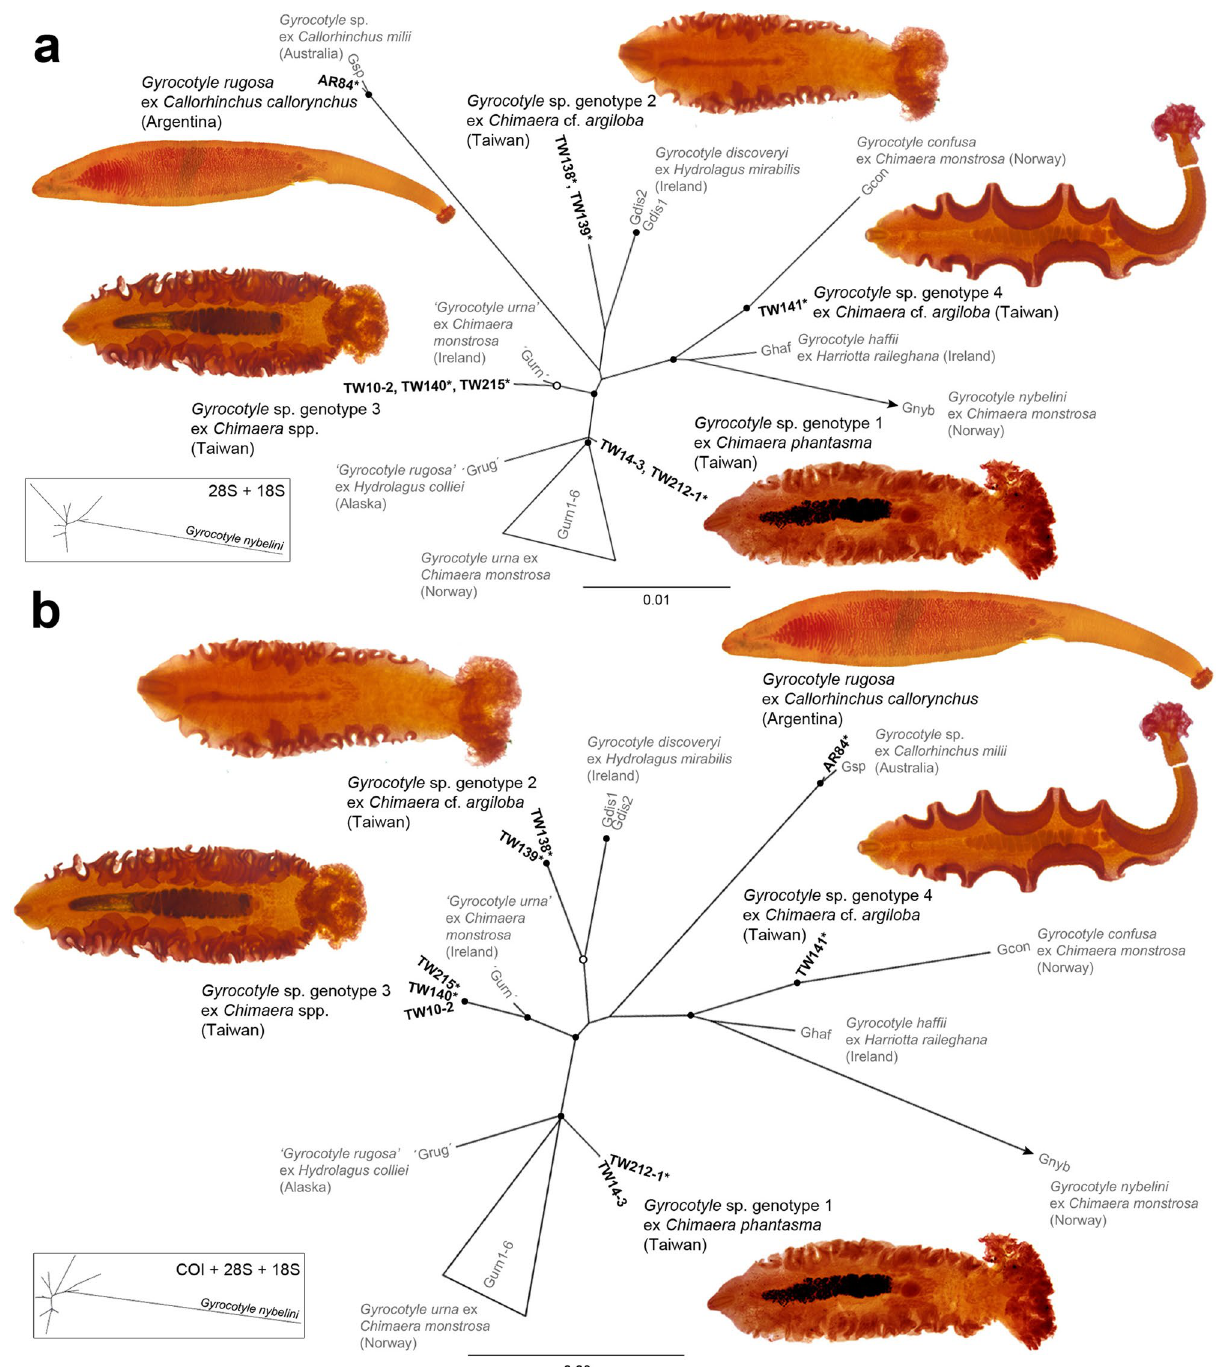
Figure 1. Estimation of genetic interrelationships among the isolates of the genus Gyrocotyle. Maximum likelihood analysis performed on two concatenated datasets of two ( 28S rRNA + 18S rRNA ) ( a ) and three ( COI + 28S rRNA + 18S rRNA ), ( b ) partial genes depicted as unrooted networks. Note the genetic diversity of the four genotypes of Gyrocotyle sp. from Taiwan, each of which clustered with G. urna off Norway + ‘ G. rugosa ’ off Alaska, G. discovery off Ireland, ‘ G. urna ’ off Ireland, and G. confusa off Norway, respectively, rather than together. Also note the cluster of Gyrocotyle sp. genotype 3 specimens isolated from Chimaera phantasma and C. cf. argiloba , respectively, and the close relatedness of Gyrocotyle rugosa from Callorhinchus callorynchus off Argentina with the isolate of Gyrocotyle sp. from Callorhinchus milii off Australia. Our original isolates are in black, with a micrograph of the morphological voucher; asterisks mark the hologenophores. The ultrafast bootstrap supports over 89% and 94% are shown as open circles and black dots, respectively. The full length of the branches and gene concatenations are in the rectangular box, the identification of isolates in Table